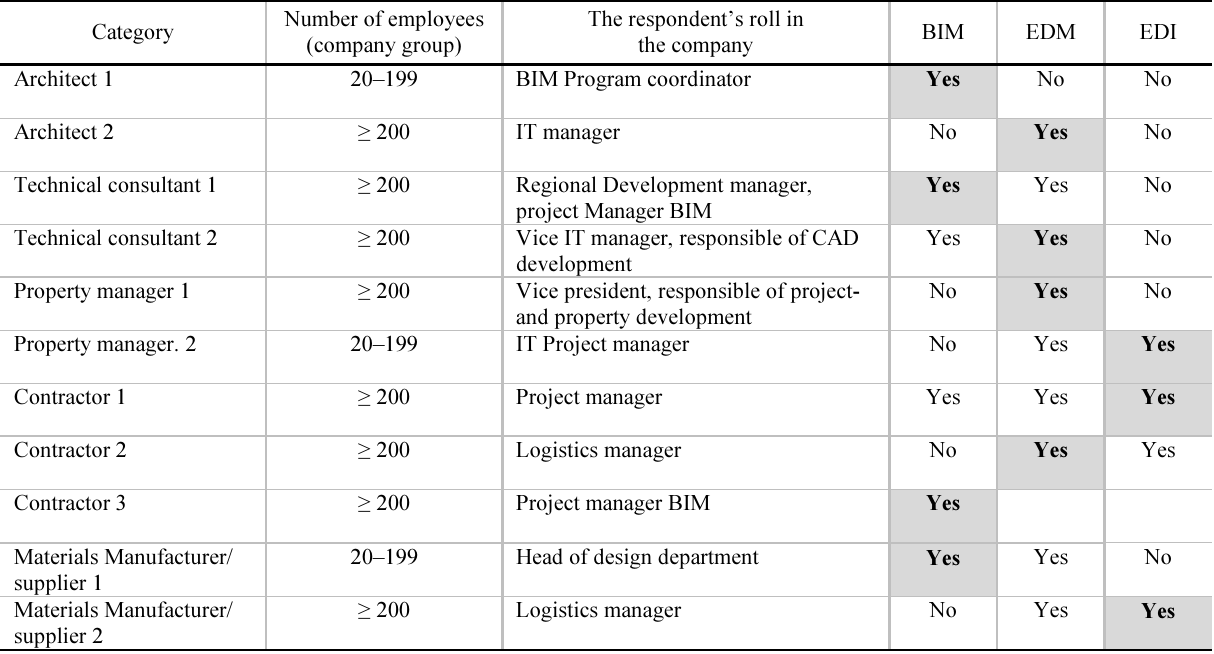
Table 2. Distribution of respondents in the second interview study